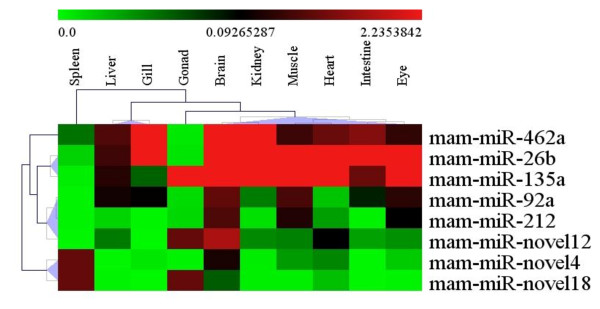
Heat map showing the 8 differentially expressed miRNAs expression patterns in 10 tissues measured by stem-loop RT-PCR. Relative expression levels of the 8 differentially expressed miRNAs were measured in terms of threshold cycle value (Ct) and were normalized to 5S rRNA. The expression data were analyzed by hierarchical clustering for both tissues and genes.